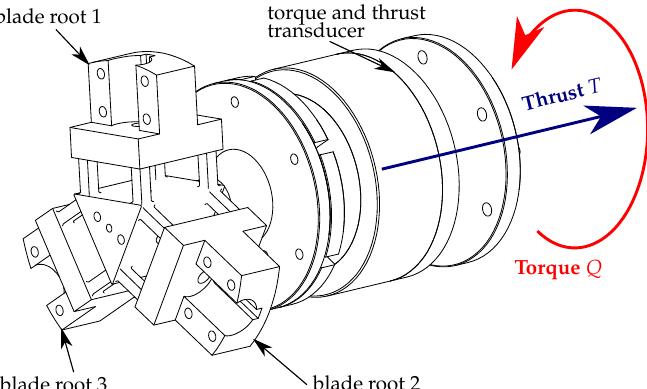
Figure 5. Schematic of the blade roots and the waterproof torque Q and thrust T